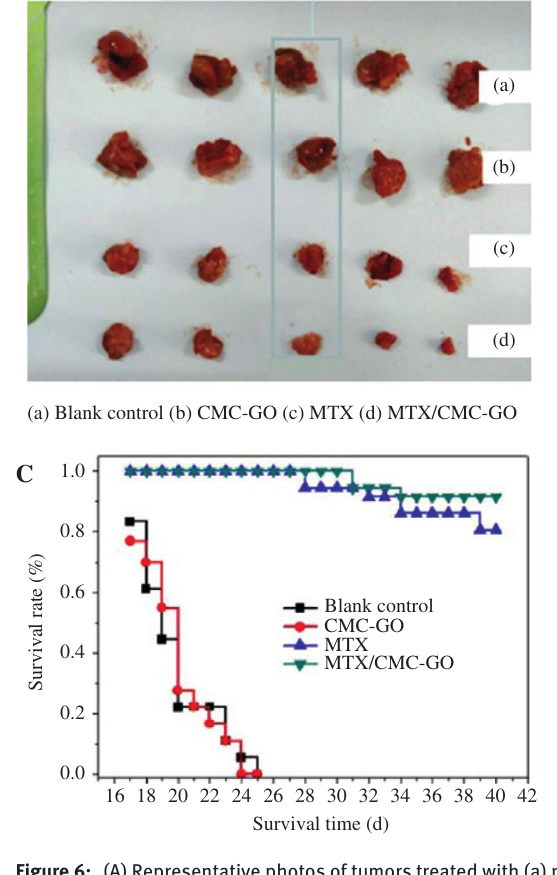
Figure 6: (A) Representative photos of tumors treated with (a) no stimulus (blank control), (b) CMC-GO, (c) MTX and (d) MTX/CMC-GO. (B) H&E staining of tumors treated with (a) no stimulus (blank control), (b) CMC-GO, (c) MTX and (d) MTX/CMC-GO; (C) Kaplan-Meier survival curve between groups (a) blank control, (b) CMC-GO, (c) MTX and (d) MTX/CMC-GO.